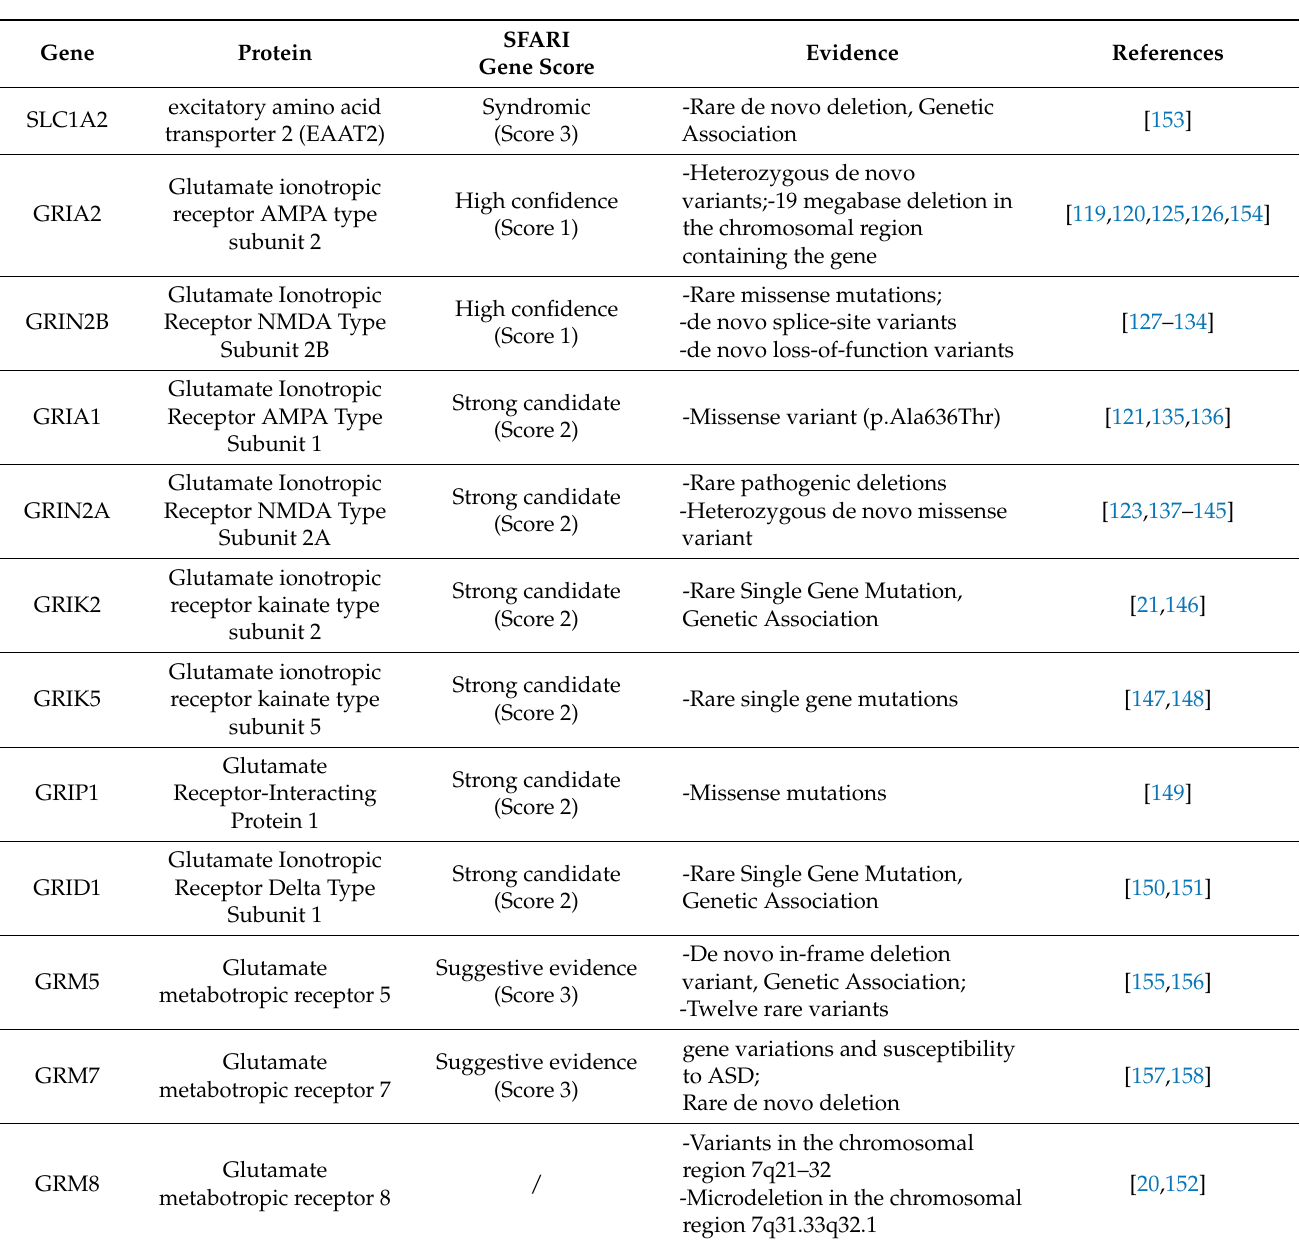
Table 1. Candidate genes implicated in